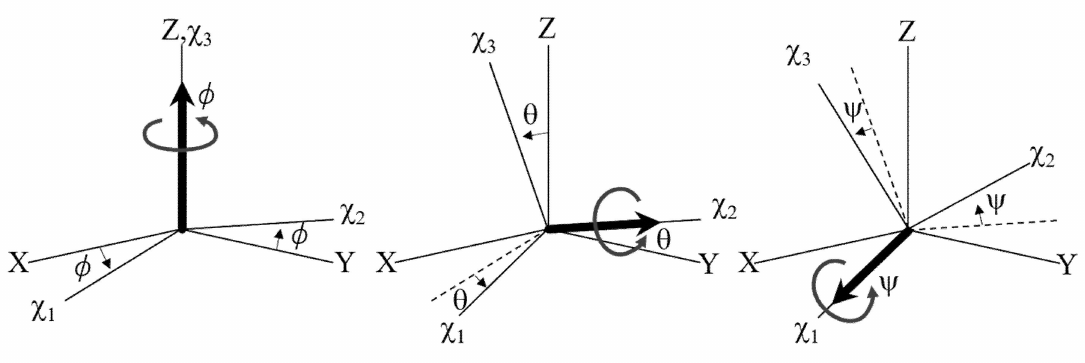
Figure 5. Euler angles φ , θ , and ψ that define the relationship between the magnetic χ 1 , χ 2 , and χ 3 axes and the laboratory coordinates X, Y, and Z. φ , θ , and ψ are consecutive rotations about the χ 3 , χ 2 , and χ 1 axes, respectively. When these angles are infinitesimally small, they correspond to the rotation about the laboratory Z, Y, and X axes,